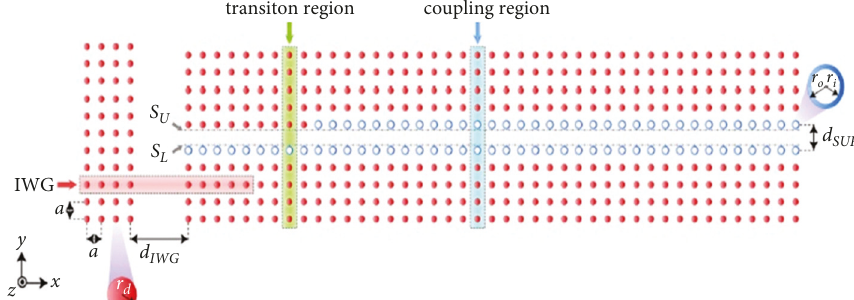
Figure 1: (Color online) geometry and organization of IWG and coupled surfaces in the square PC. Definitions of geometrical parameters are presented in the enlarged sketches. Vertical and horizontal dashed rectangles represent the supercells for calculating localized modes of respective structures. Horizontal dashed lines denoted by S U and S L represent the regions to probe mode coupling between surfaces.